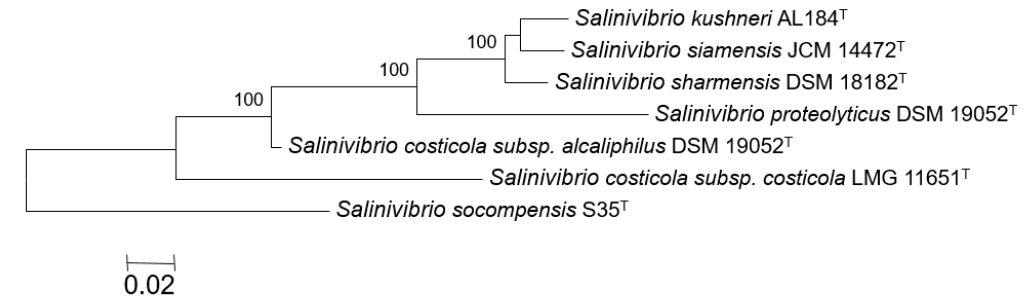
Figure 2. Approximately maximum likelihood tree based on the nucleotide sequences of the core genome (1265 genes) of strain S35 T and the type strains of the genus Salinivibrio . Bootstrap values over 70% are shown at the nodes. Bar, 0.02 substitutions per nucleotide position.